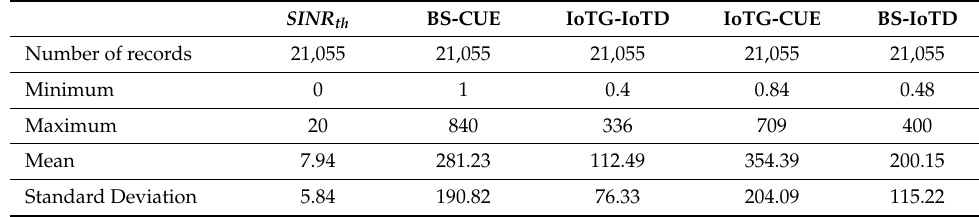
Table 3. Statistical description of features in the generated Downlink